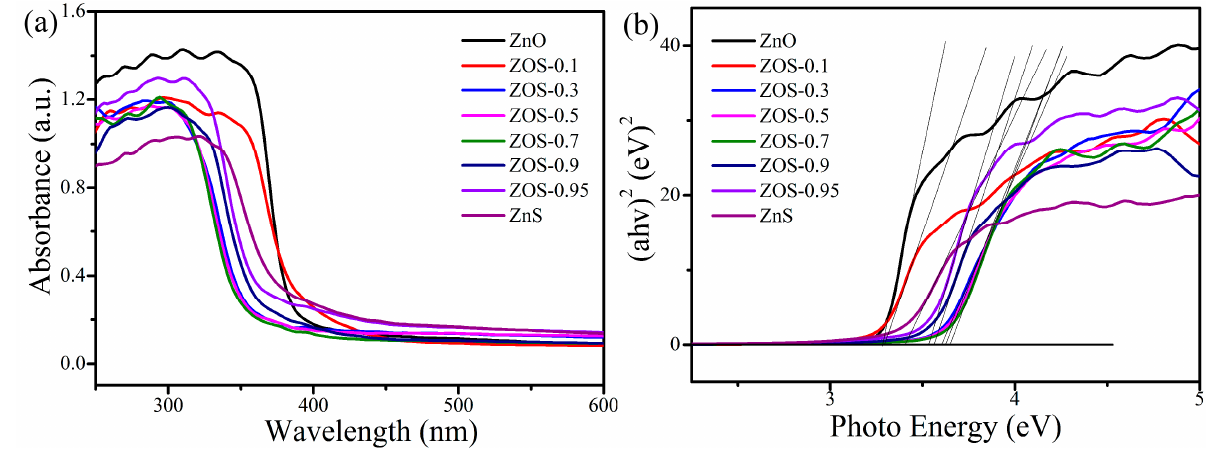
Figure 5. ( a ) UV-vis DRS, and ( b ) ( α h ν ) 2 versus h ν of ZnO, ZnS, and ZnO/ZnS photocatalysts.